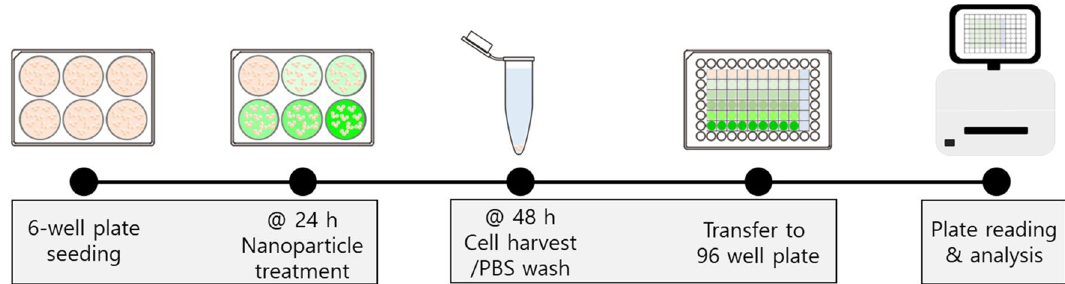
Figure 1. Overall experimental procedure for nanoparticle uptake analysis including cell seeding, nanoparticle treatment, cell harvesting and washing, and plate reading and